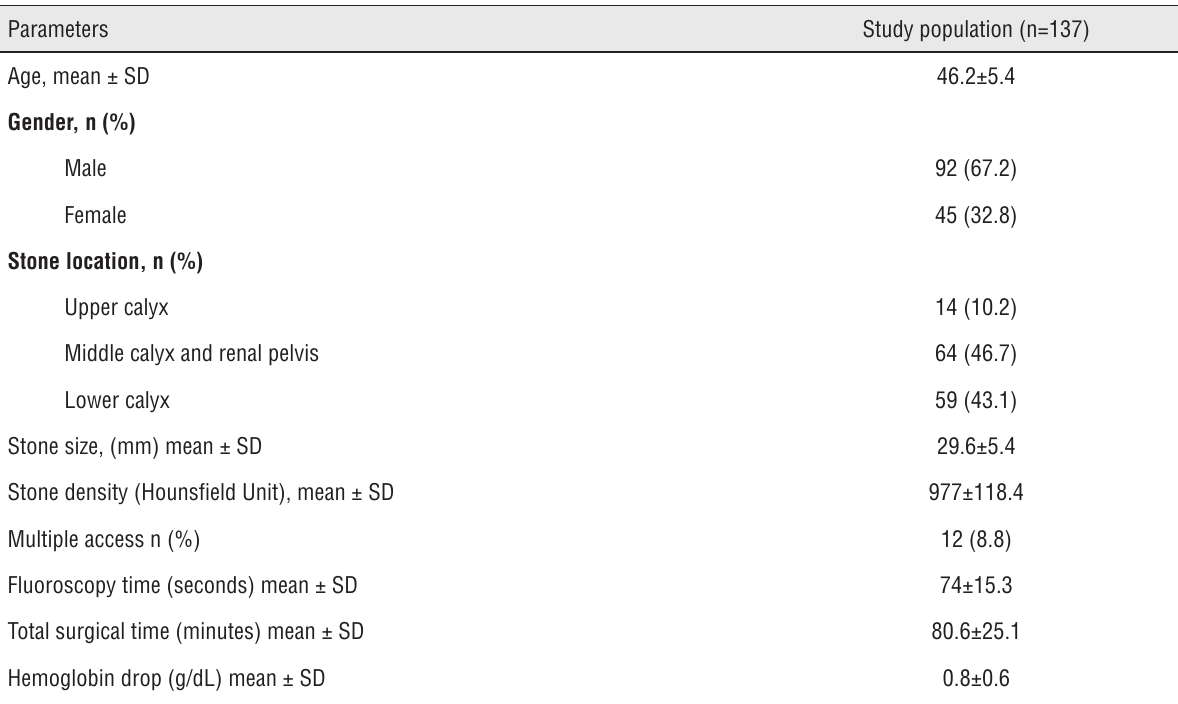
Table 1 - Demographic, stone related, and operative characteristics of the study